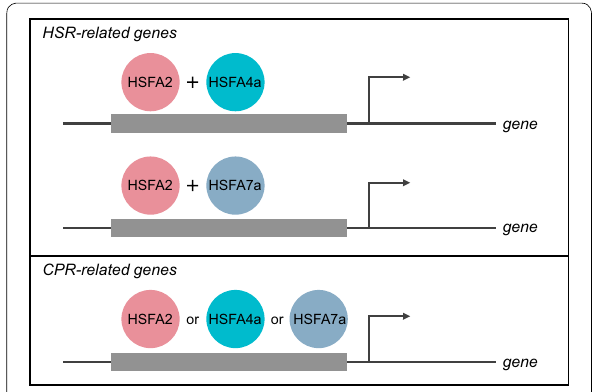
Fig. 5 Working model of the AtHSFs involved in HSR and CPR. Gray bar indicates the promoter region of HSR‑ and CPR‑related genes. Arrow indicates transcription starting